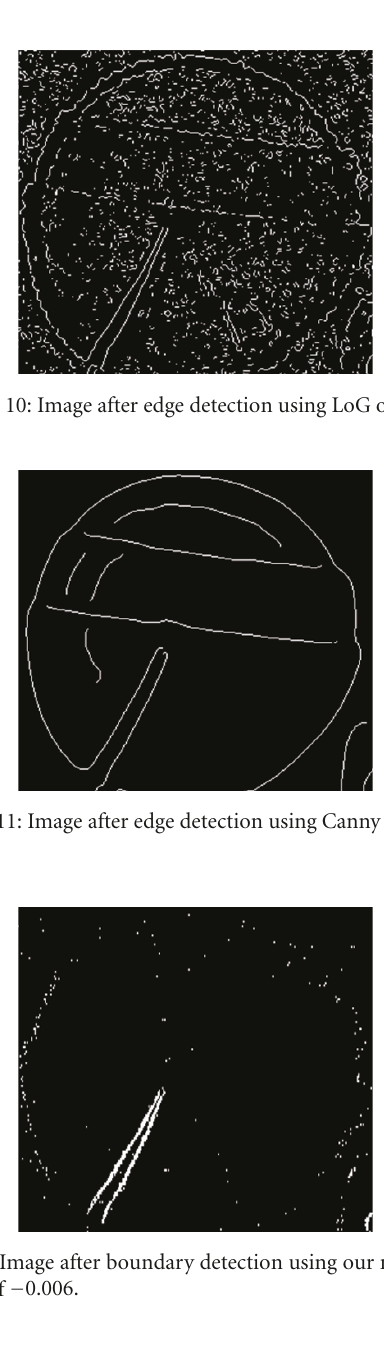
Figure 7: Image after edge detection using Sobel operator.